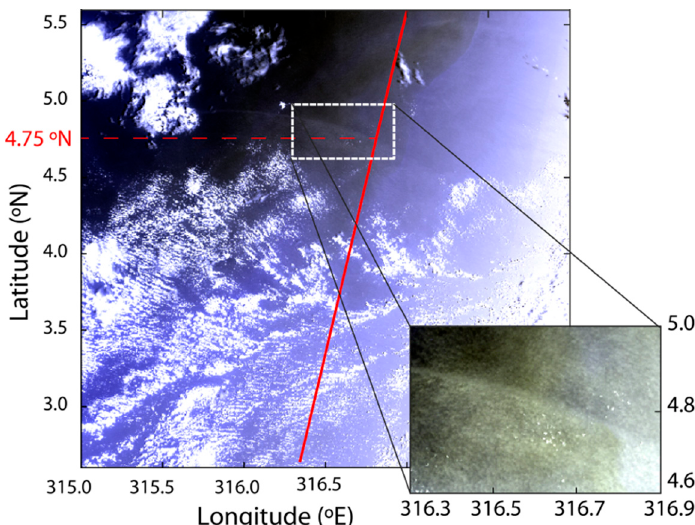
Figure 7. Sentinel-3A ocean and land color instrument (OLCI) image dated 27 September 2018 from relative orbit 152 of cycle 036 showing a large amplitude ISW. The along-crest length extends for some 100 km, and is crossed by the altimeter satellite track (in red) at approximately 4.75 ° N (see also zoom in the inset of low right corner). Note the coincidence of the OLCI internal wave feature, pointed out by the dashed red line with corresponding latitude written in the y -axis, with the SRAL detected ISW feature in Figure 6.